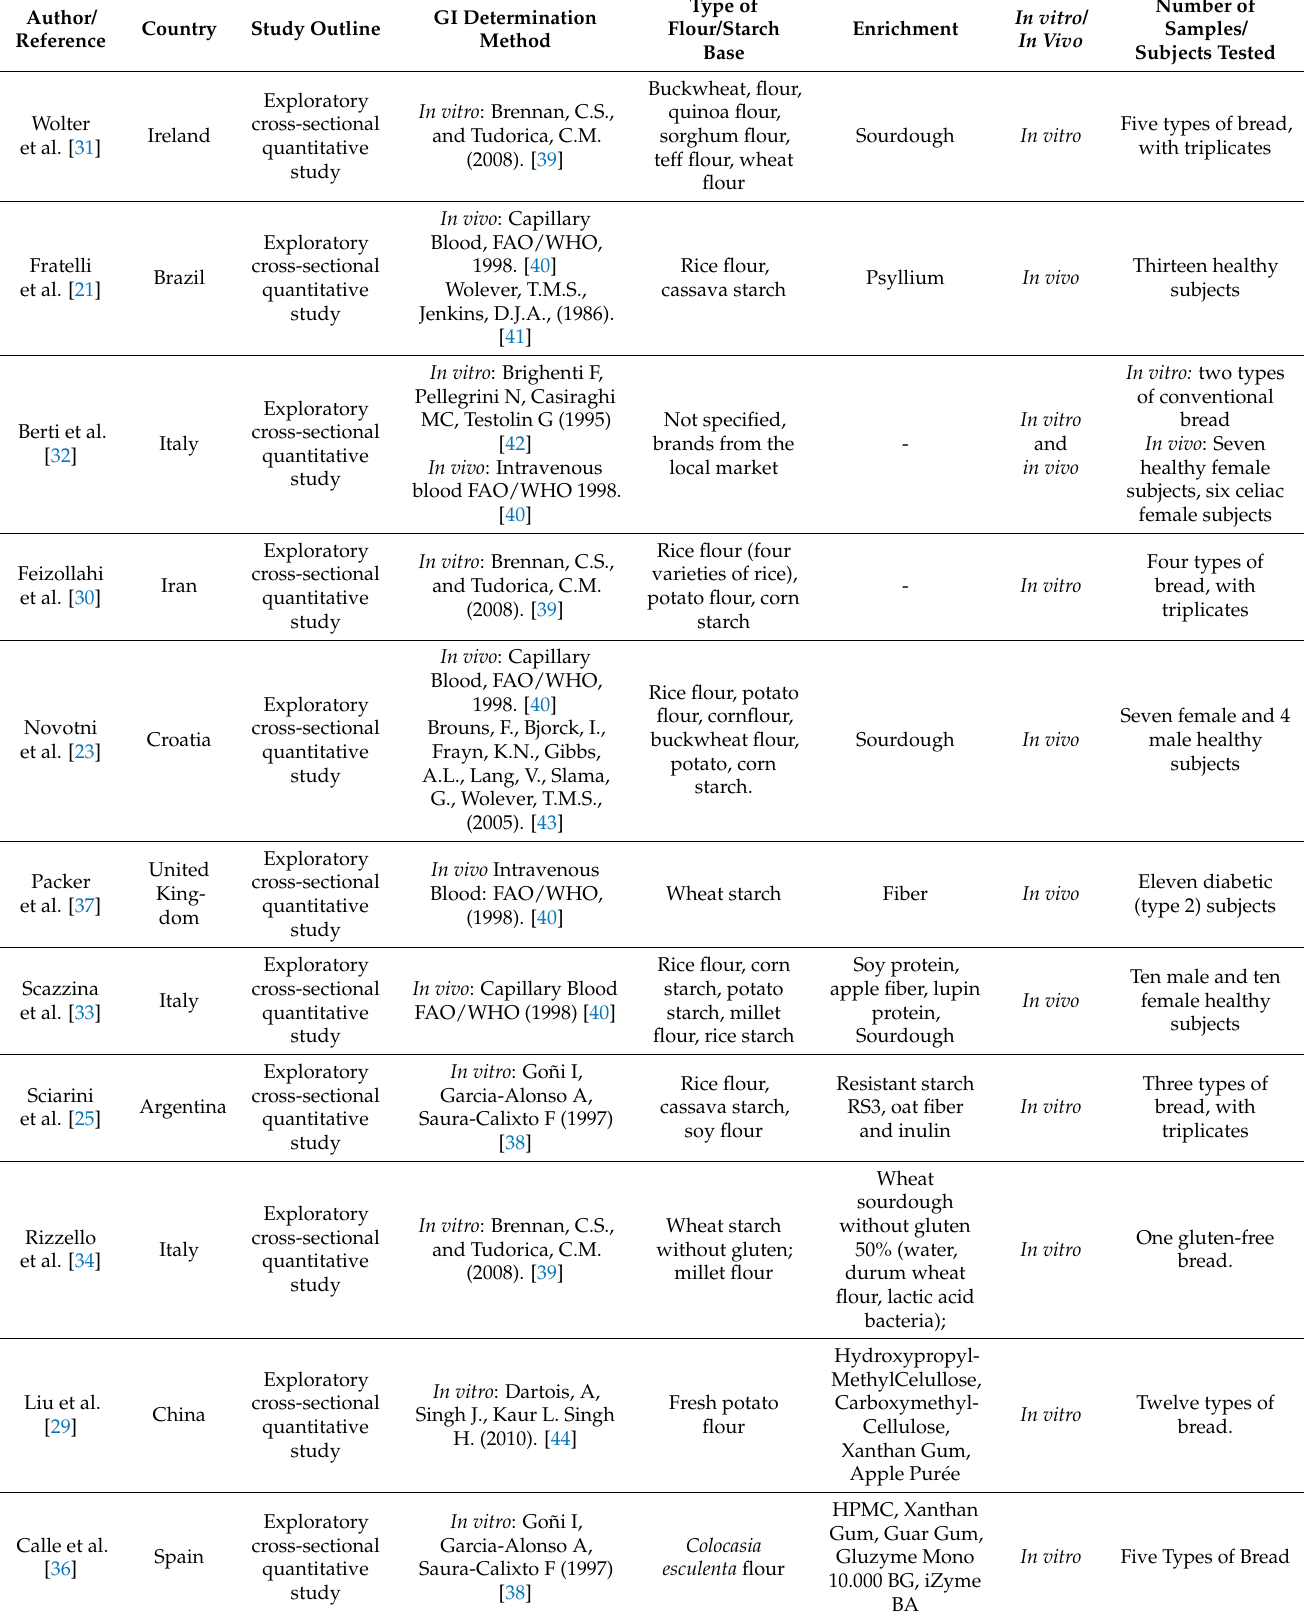
Twelve types of